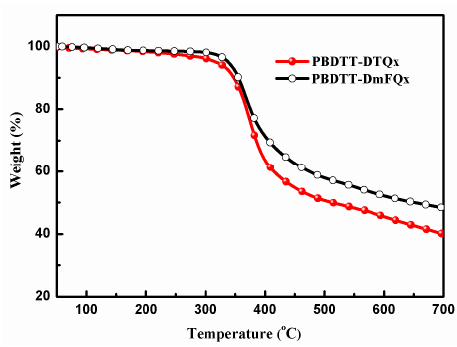
Figure 1. Thermogravimetric analysis (TGA) curves of the copolymers.